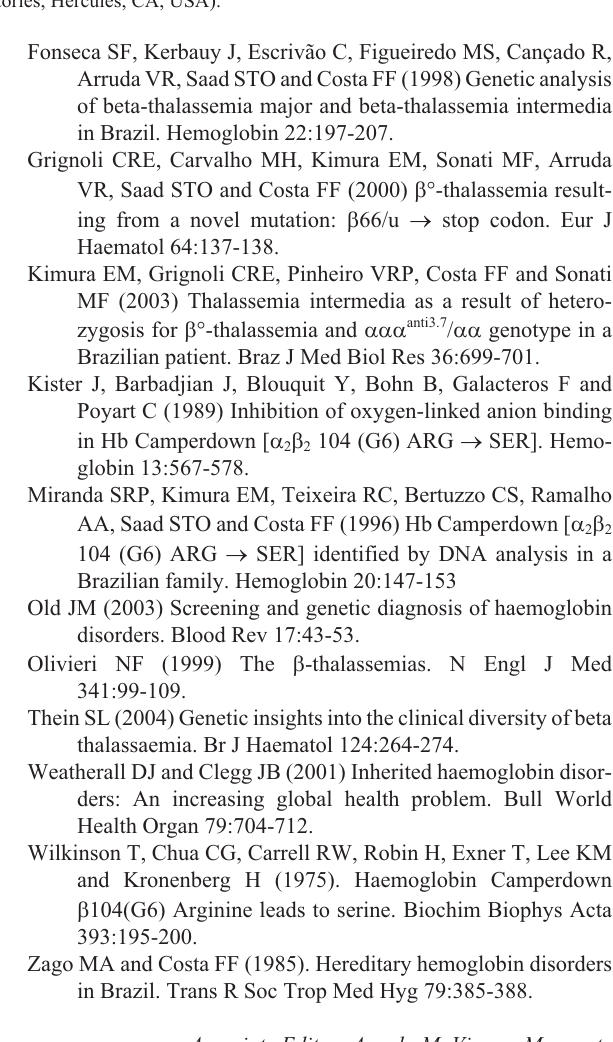
Propositus [g. 115 C >